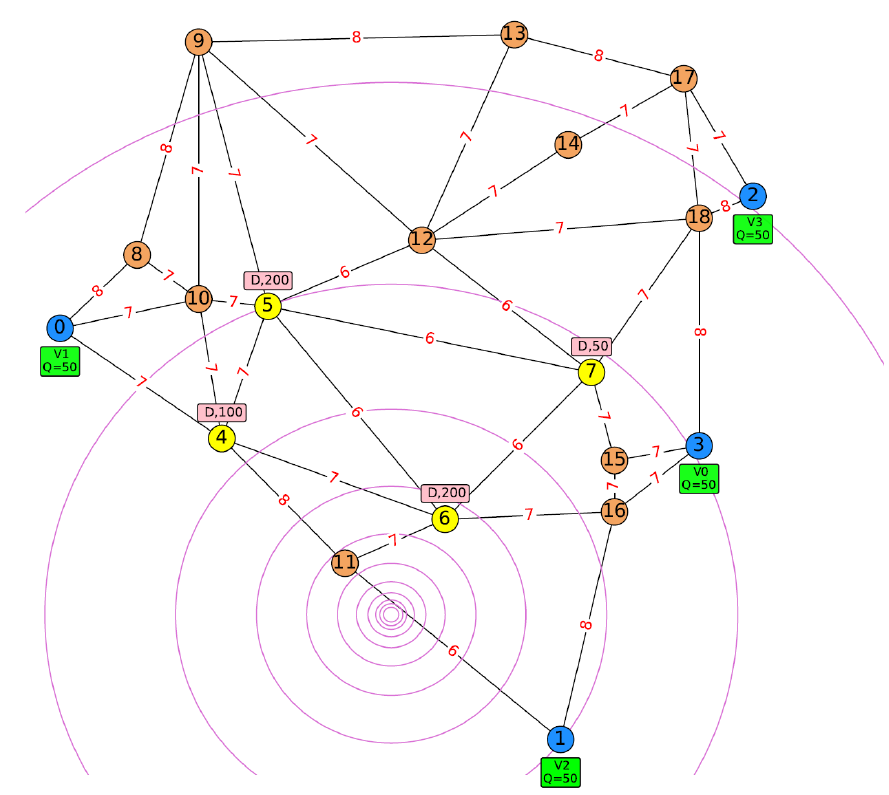
Figure A2. Road network for instance D4N11S4 [15].